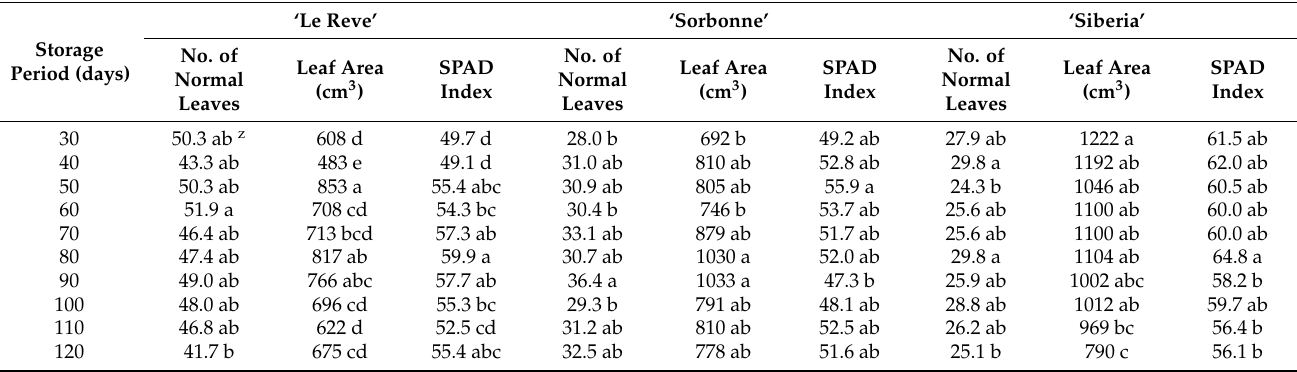
commercial quality parameters. Table 1. Number of leaves, leaf area, and SPAD index (chlorophyll content) at the harvest of cut flowers as affected by bulb storage period at 0 ◦ C in Lilium Oriental Hybrids ‘Le Reve’, ‘Sorbonne’, and ‘Siberia’. ‘Le Reve’ Storage Period (days)